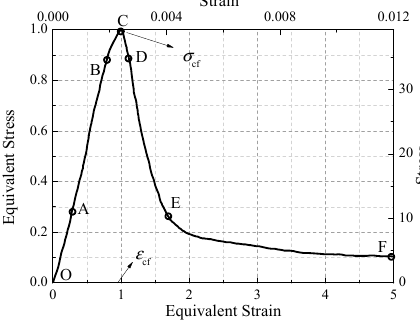
Figure 2. Typical stress-strain curve.